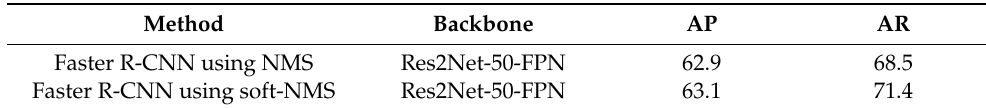
Table 5. Detection result with NMS and soft-NMS. AP and AR mean average precision and average recall, respectively. (unit: %).